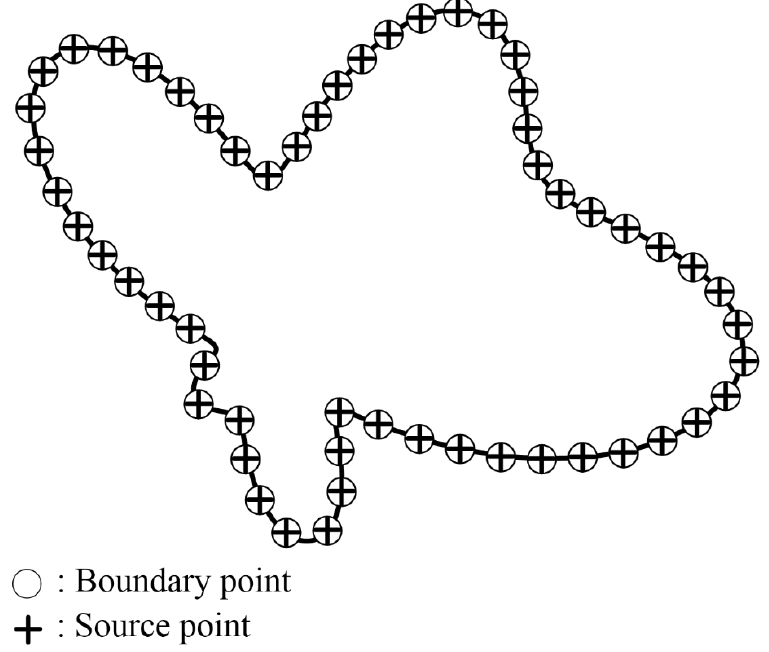
Figure 7. Boundary and source points for an amoeba-shaped boundary.